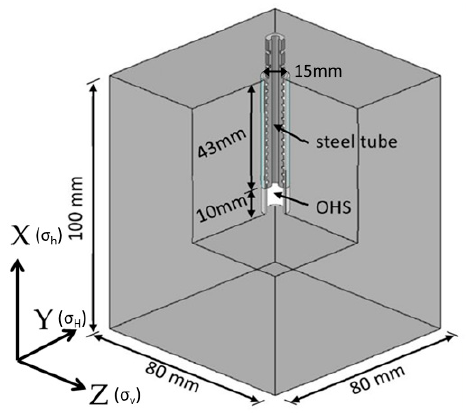
Figure 4. Schematic of fracturing specimen.